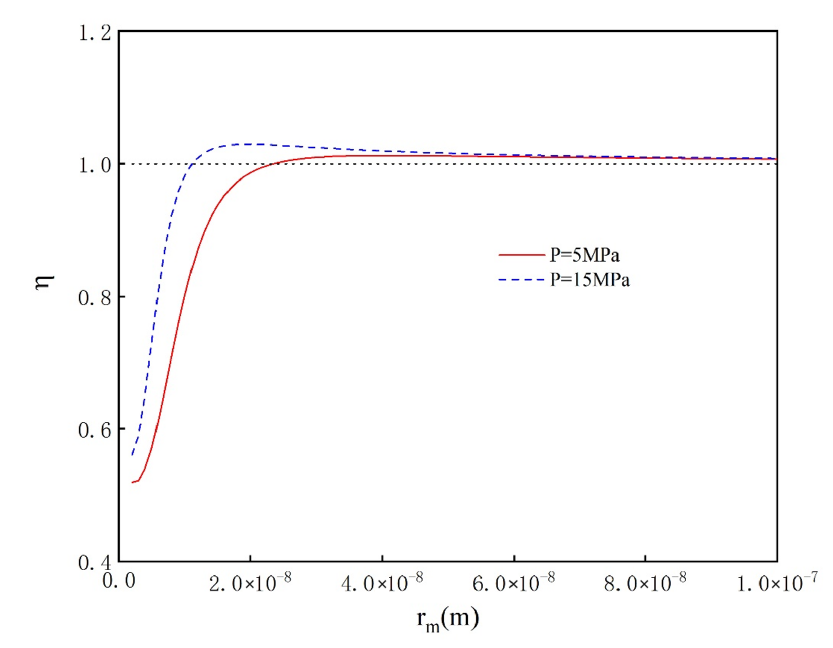
Figure 11. Characteristic parameters vs. pore radius under different